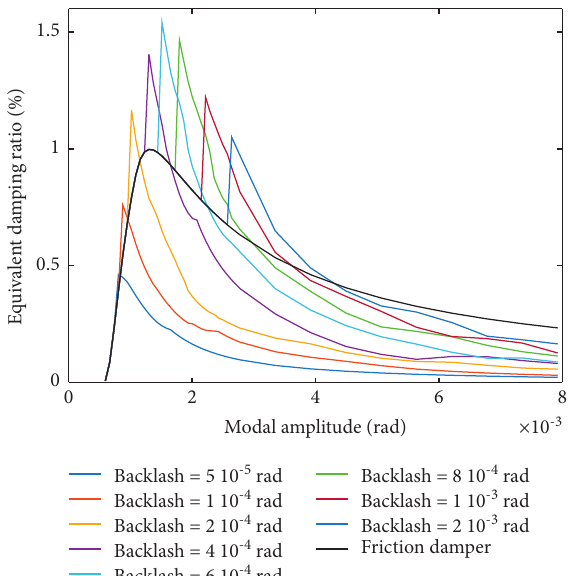
Figure 10: Influence of the mechanical backlash on the damping effect of the shock-friction damper.